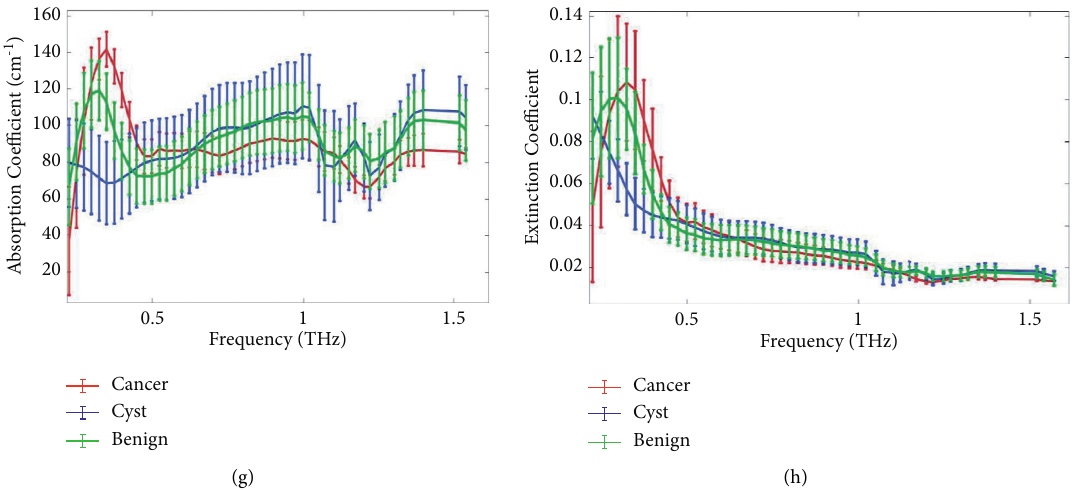
Figure 2: (a) The time-domain spectral line from the sample surface. (b) Frequency domain spectral lines passing through the sample surface. (c) Refractive index. (d) Absorption coefficient spectra. (e) Extinction coefficient spectra. (f) Mean refractive index of oral cancer, benign and cyst. (g) Mean absorption coefficient of oral cancer, benign and cyst. (h) Mean extinction coefficient of oral cancer, benign and cyst. The blue, red, and green lines indicate the oral squamous cell carcinoma, benign (ameloblastoma), and cyst, benign sample, the pink line indicates the malignant sample, and the black line indicates the reference sample.